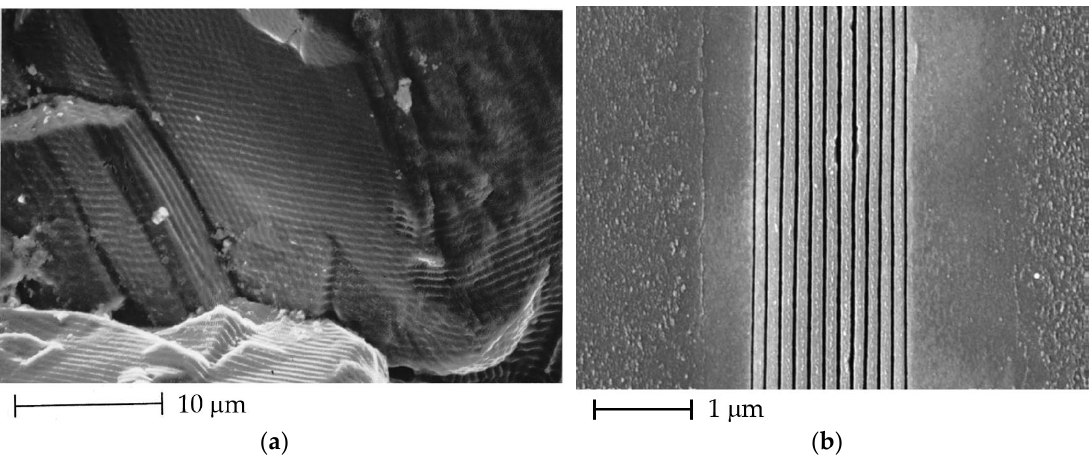
Figure 5. Scanning electron micrographs of: ( a ) unpolished CVD diamond irradiated with a Ti–sapphire fs laser (fluence of 2.5 J/cm 2 , 1000 pulses, pulse length 150 fs, λ = 825 nm) with a single interference pattern on the lower grain and two interference patterns crossing each other at 90 degrees on the upper grain [56](Copyright 1999 AIP Publishing); ( b ) The diamond surface after irradiation with a 1000 pulse train of 120 ‐ fs laser pulses at a rate of 250 kHz with a pulse energy of 72 nJ, where the polarization and the scanning directions are indicated by the dotted and solid arrows, respectively [59]. (Copyright